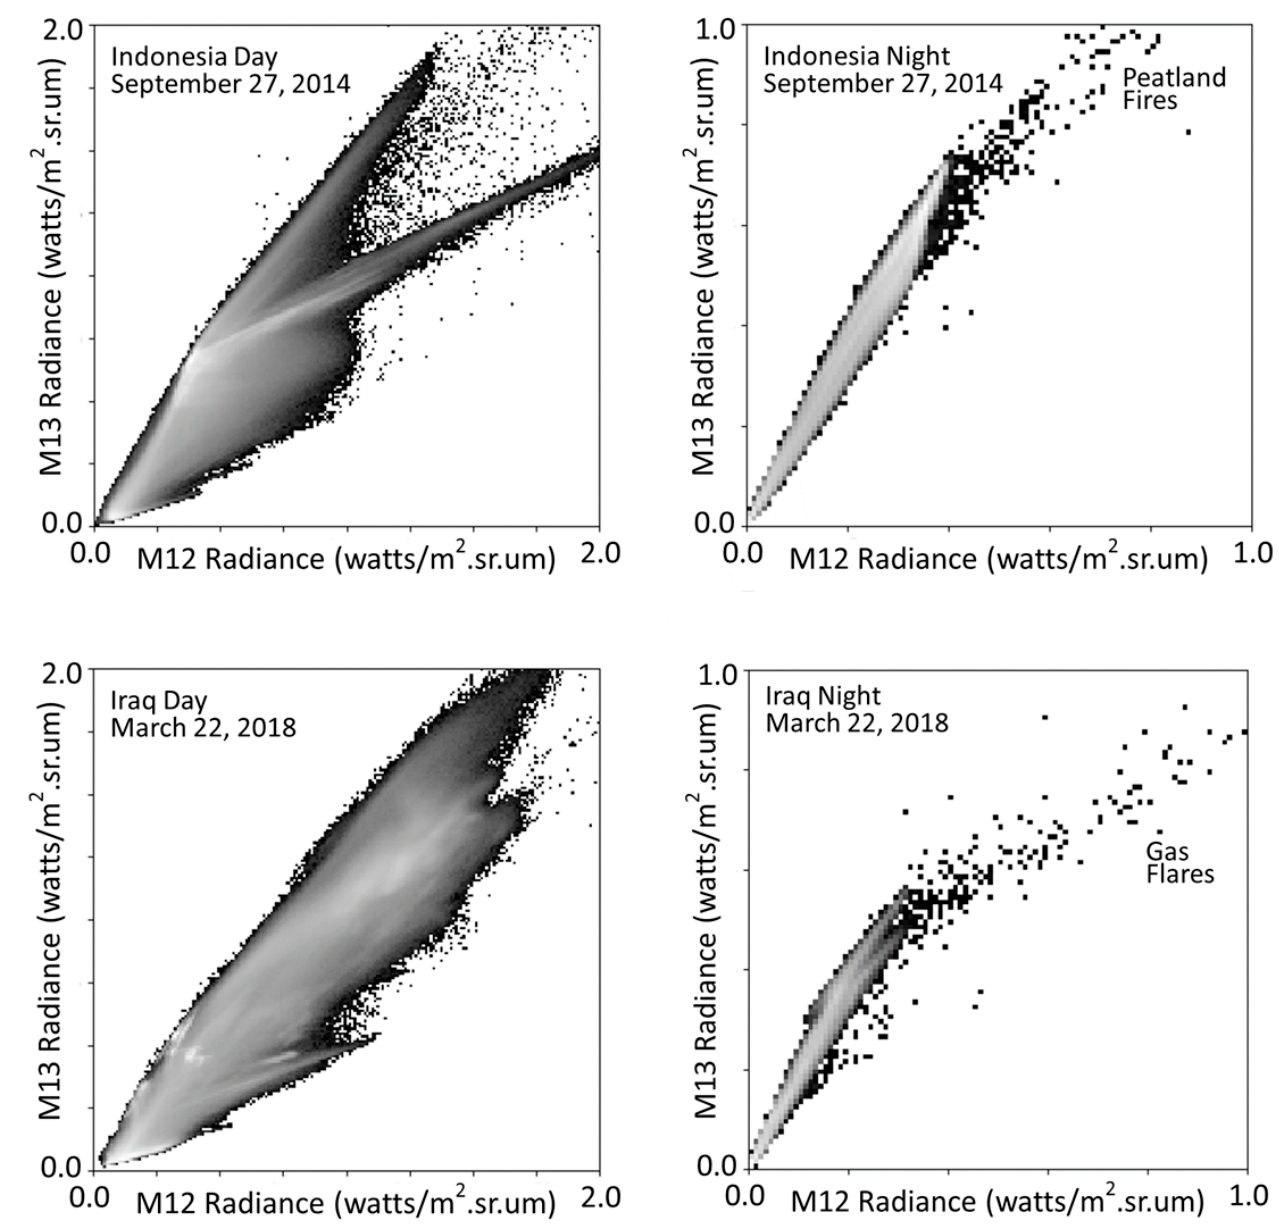
Figure 4. Daytime versus night-time M12 versus M13 scattergrams for VIIRS granules containing subpixel IR emitters in Indonesia and Iraq. Portions of the Iraq granule are shown in Figure 3. The diagonal background feature is only evident at night. The feature is dissipated during the day due to reflected sunlight.